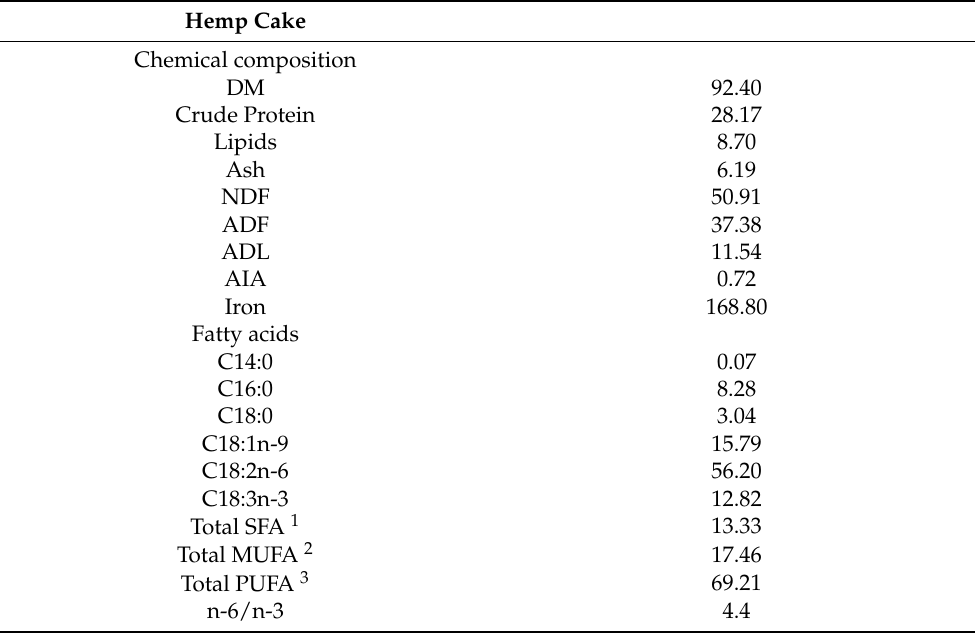
Table 1. Chemical composition (% on DM), iron content (mg/kg) and fatty acid profile (g/100 g of total FA) of the hemp